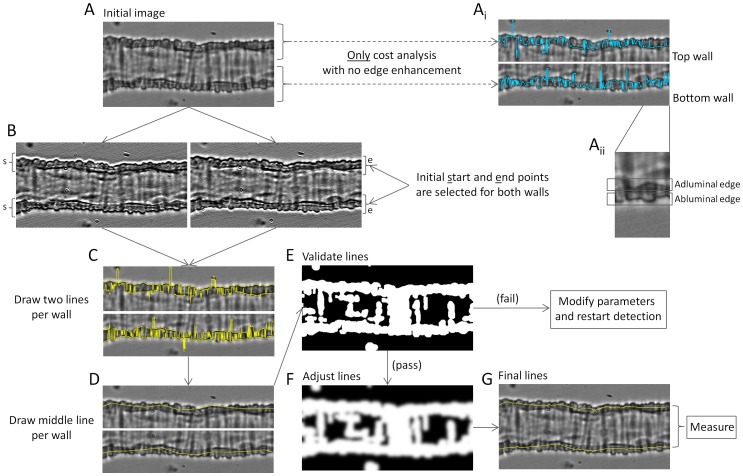
Description of the algorithm.A. Image of retinal arteriole under no pressure conditions and at 37°C. Ai. Top and bottom walls from the arteriole. The blue lines superimposed are drawn by applying only cost analysis with no edge enhancement. Initial start and end points are used here as part of the cost function detection as shown below in B. Aii. Inset zoomed from the bottom wall in Ai illustrating adluminal and abluminal edges. B. Left and right panels correspond to images obtained from the vessel in A after convolving with 2 different kernels. Left image shows more pronounced top adluminal and bottom abluminal edges. Right image shows more pronounced top abluminal and bottom adluminal edges. Initial start (s) and end (e) points are also marked in the images. C. Top and bottom walls as in A. The 4 yellow lines superimposed correspond to the detected abluminal and adluminal edges in both walls. D. Estimated mid-wall lines (in yellow) are shown superimposed on the walls of the vessel. E. Binary image used for validation of the middle lines. If the validation fails, parameters are modified (as shown in Fig. 2) and detection is restarted. F. Modified binary image used to adjust the middle lines. This is obtained by applying a Gaussian filter and dilation on the image in E. G. The final lines obtained are superimposed on the vessel in yellow. These are the lines used to measure the diameter of the vessel.